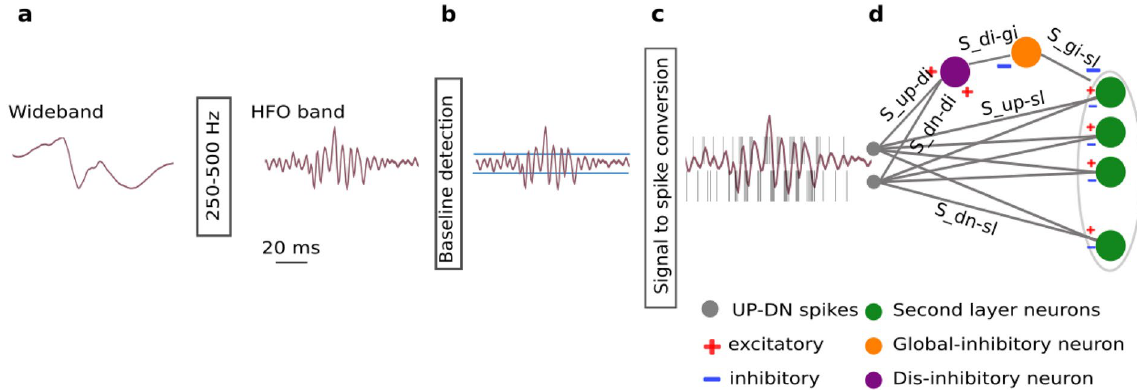
Figure 1. HFO detection scheme. (a) The wideband ECoG is filtered in the HFO frequency band (250–500 Hz). (b) In the baseline detection stage, the background noise of the signal is used to set the signal-to-spike threshold. (c) The signal-to-spike conversion algorithm converts the analog signal into two streams of digital outputs: UP and DN spikes. (d) The SNN architecture for HFO detection and artifact rejection consists of input neurons (grey) receiving the input UP-DN spikes. These inputs project to a second layer of neurons (green) and to a dis-inhibitory neuron (purple). This neuron projects inhibitory synapses to a global-inhibitory neuron (orange), which is continuously inhibiting the second layer neurons. The synapses of the projections are excitatory (positive, red) or inhibitory (negative, blue).